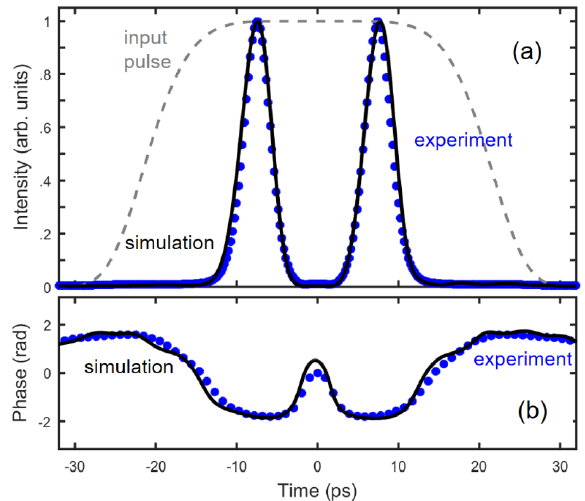
Fig. 3. Details of the temporal intensity and phase profiles (subplots a and b, respectively) obtained for an input average power of 80 mW. Experimental results (solid black lines) are compared with numerical simulations of the NLSE (blue full circles). The input intensity profile is plotted with a dashed grey